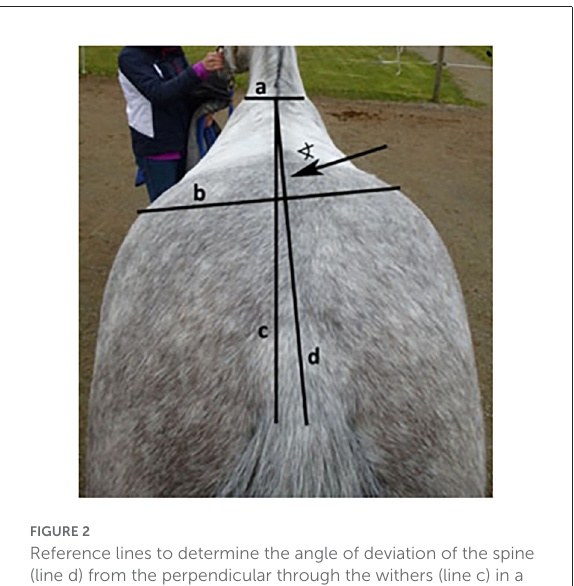
FIGURE2 Reference lines to determine the angle of deviation of the spine (line d) from the perpendicular through the withers (line c) in a horse with its hindquarters displaced to the right, using the shoulders (line a) and tuber coxae (line b) as anatomical